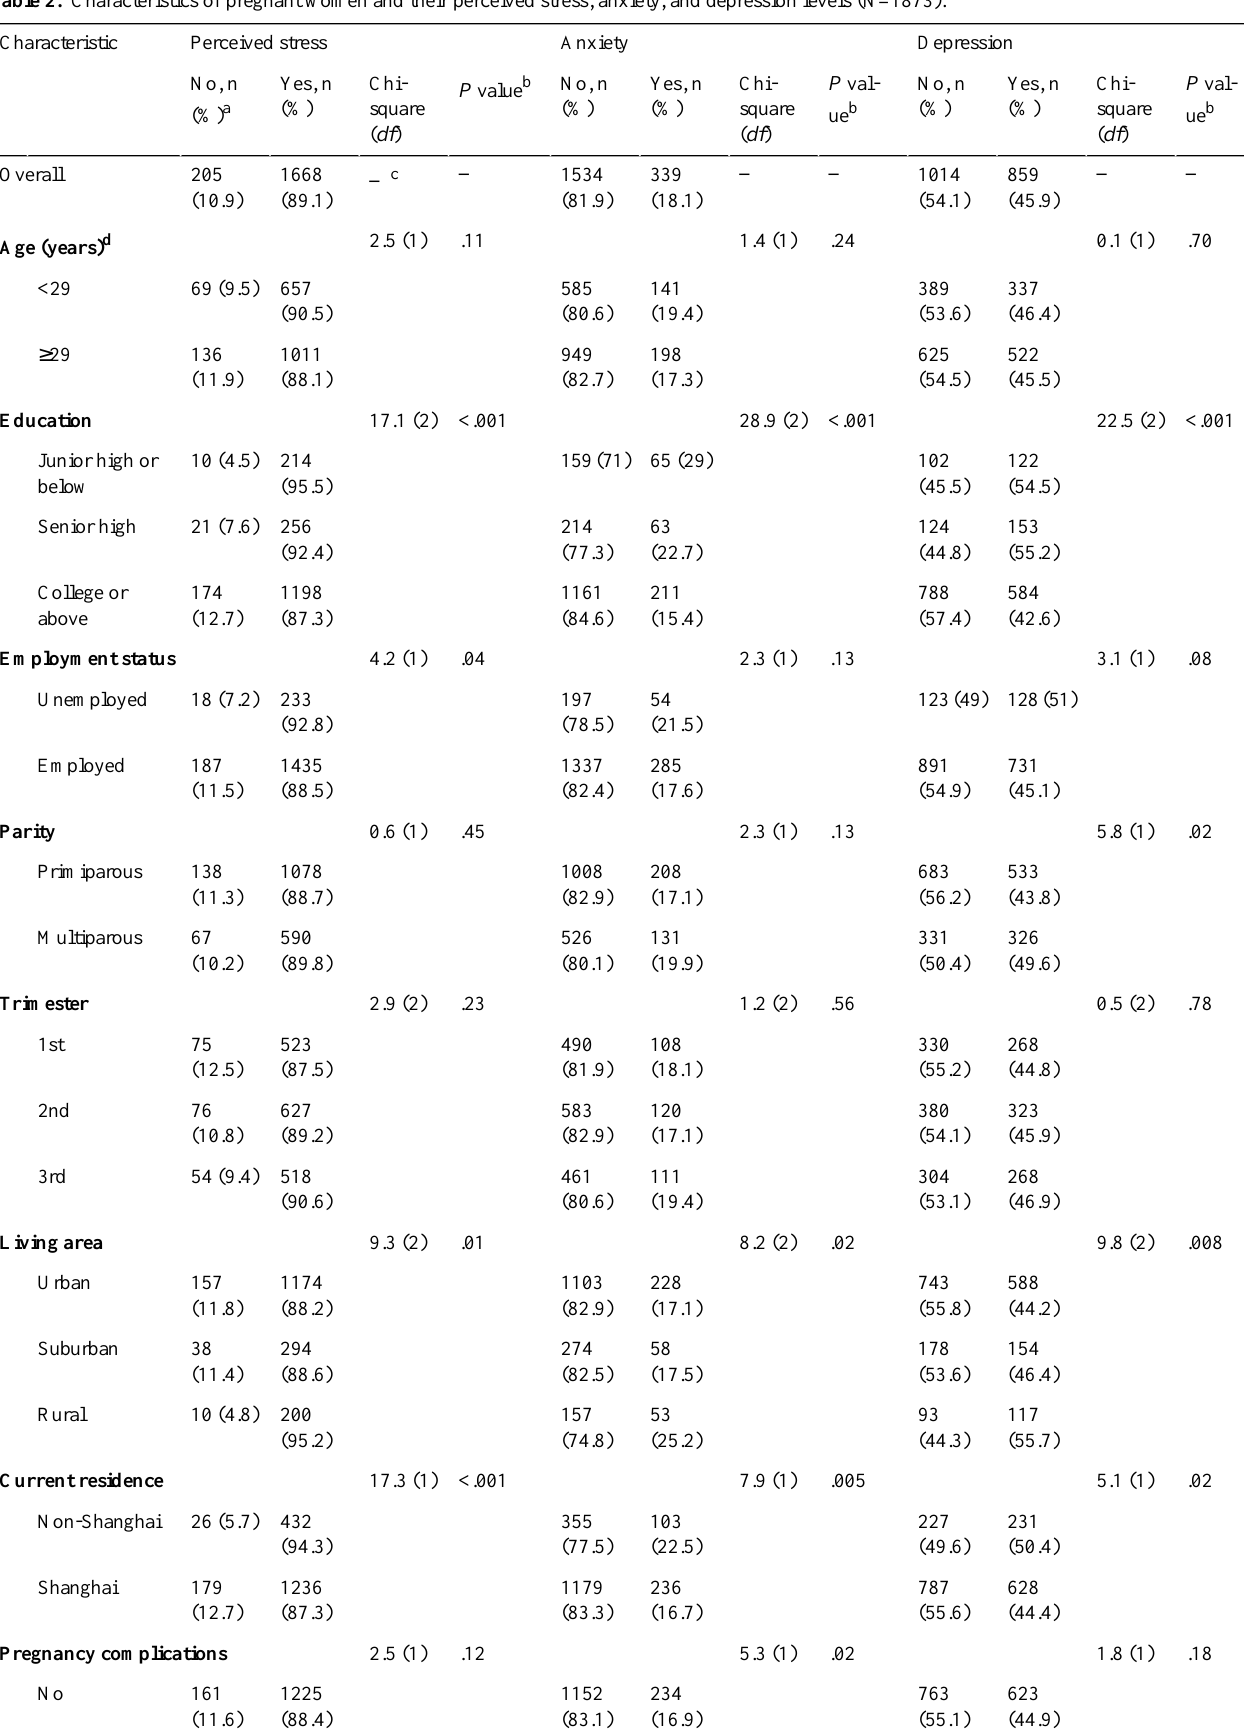
Table 2. Characteristics of pregnant women and their perceived stress, anxiety, and depression levels (N=1873). DepressionAnxietyPerceived